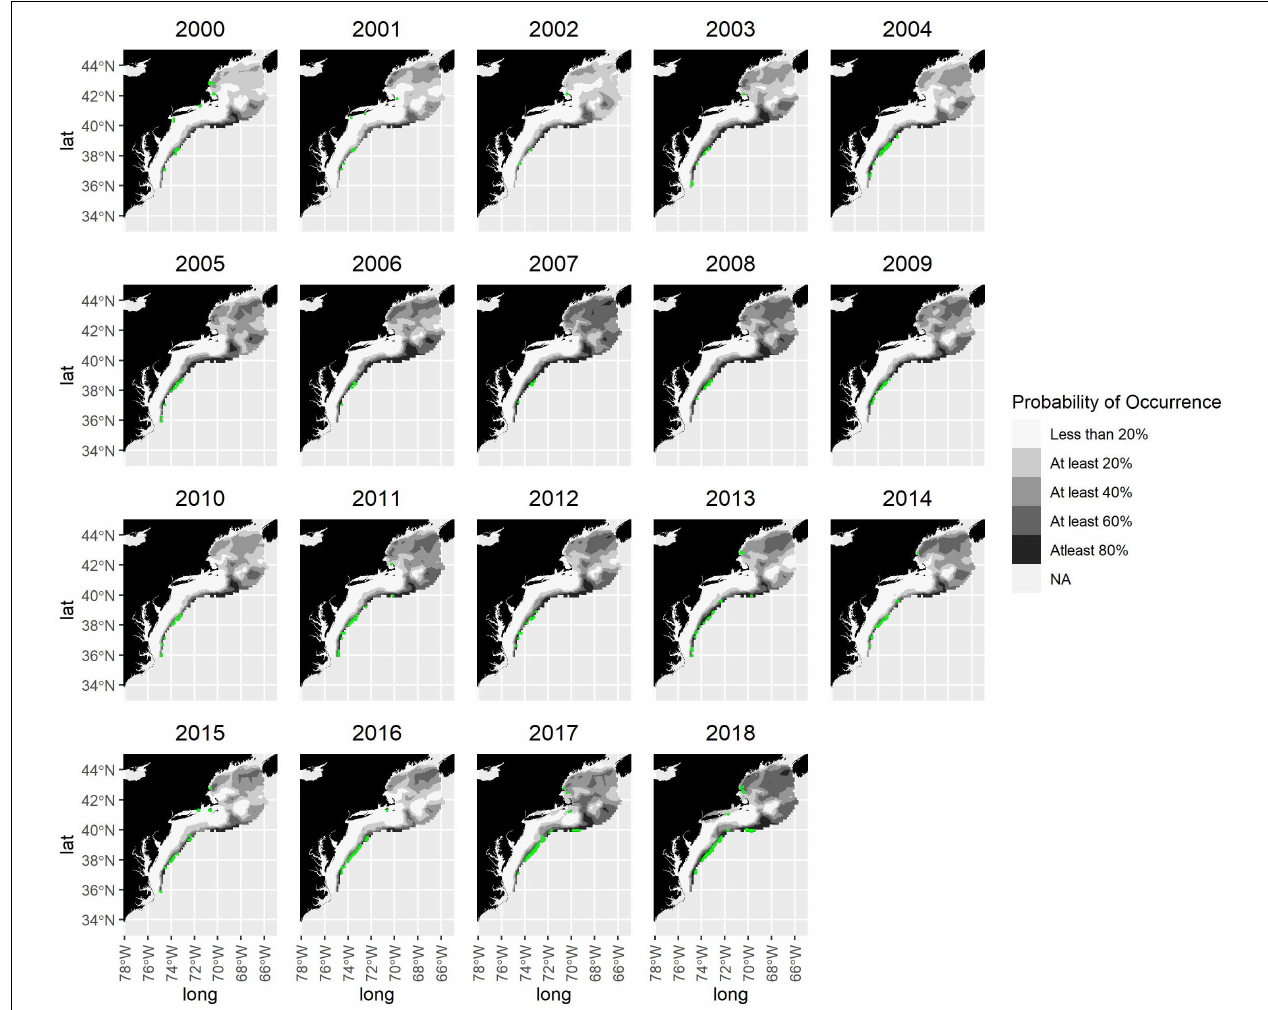
FIGURE 4 | Shortfin squid probability of occurrence map. Quintiles of probability of occurrence are shown in shading. Locations of fishing effort aggregated to 5-min squares are shown in green. Note that some areas of fishing effort have been excluded from the figure to maintain